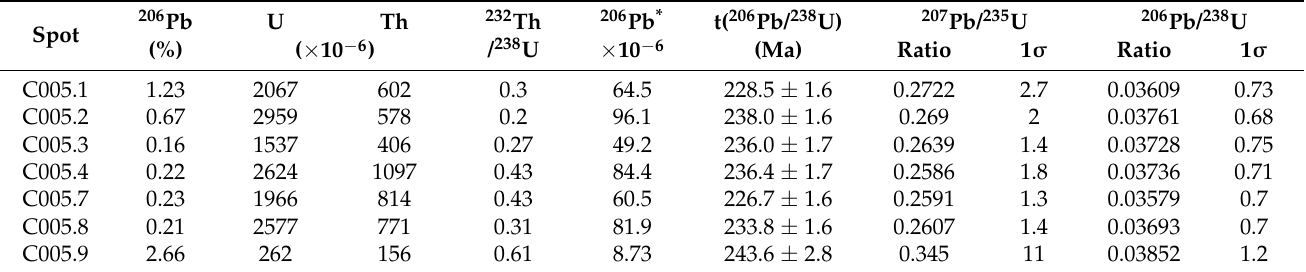
Figure 7. SHRIMP U–Pb Concordia diagram and CL images of zircons from the Tianzishan Figure 7. SHRIMP U-Pb Concordia diagram and CL images of zircons from the Tianzishan monzogranite. monzogranite. Table 4. SHRIMP zircon U-Pb dating of the Tianzishan monzogranite.